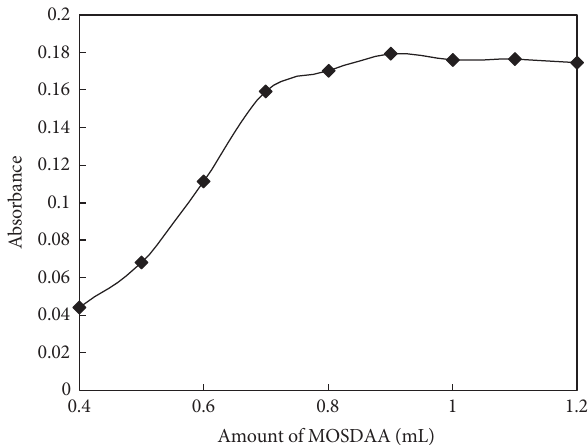
F 4: Effect of the amount of MOSDAA on the absorbance of Co(II). Conditions: